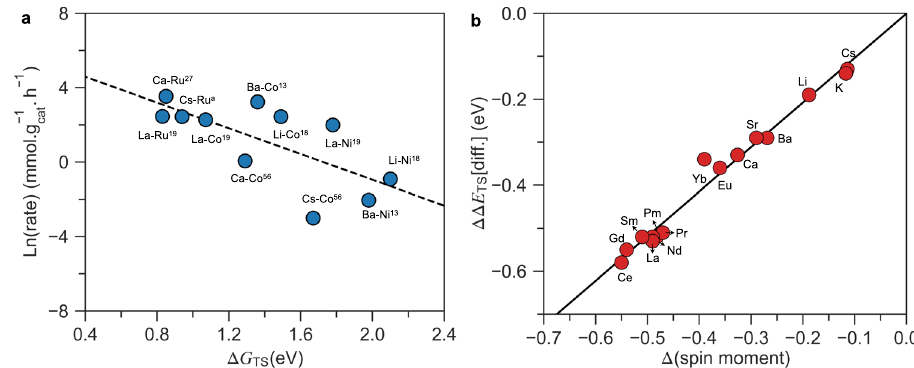
Fig. 4 The application of the proposed spin effect. a The experimental activity as a function of calculated transition state free energy. The references for these catalysts are marked with superscripts. Superscript “ a ” indicates the prepared RuCs/C catalyst in this work. b The difference ΔΔ E TS [diff] = ΔΔ E TS (spin polarized) – ΔΔ E TS (non-spin polarized) between the TS energy for spin-polarized and non-spin-polarized Co plotted as a function of the promoter- induced change in spin moment of the Co atoms at the active